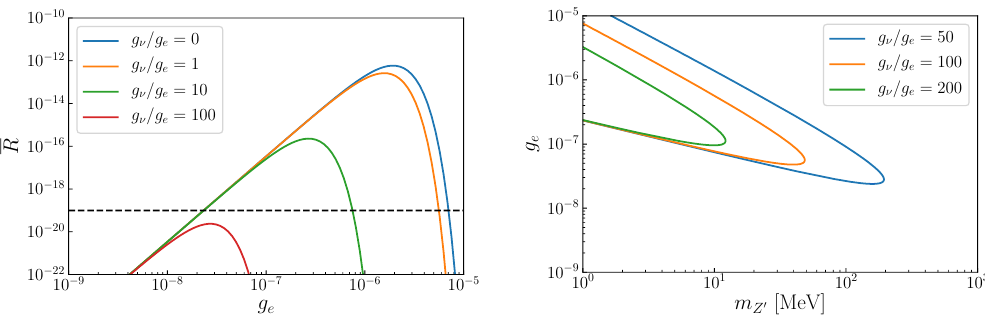
Figure 3 . Left: the dimensionless event rate R (defined in eq. (3.8)) as a function of g e and g ν , fixing m = 100 MeV. The black horizontal line represents a hypothetical experimental sensitivity Z 0 at R = 10 − 19 for the purpose of illustration. Right: contours of R ( m the different hypothetical experimental sensitivities to m